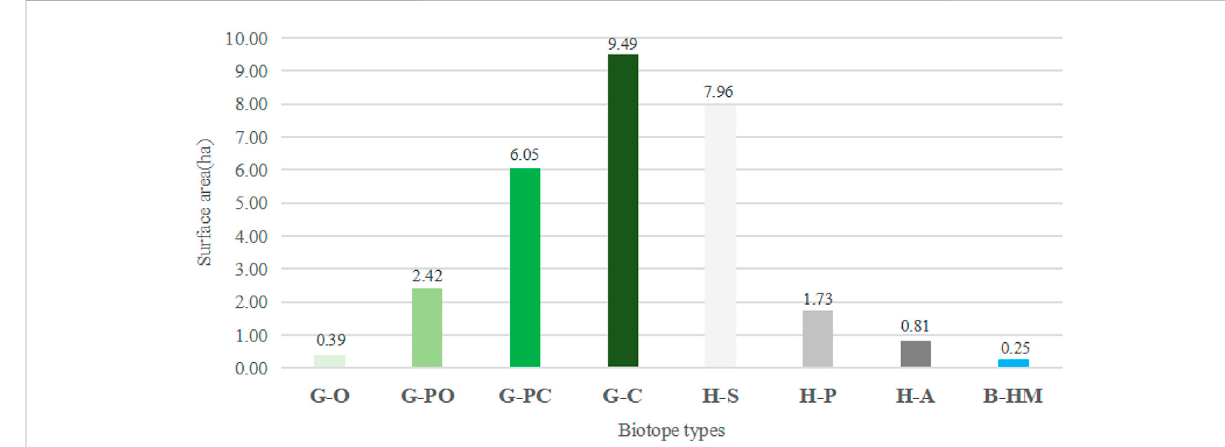
FIGURE 5 Area of biotope types in Riverside Park.